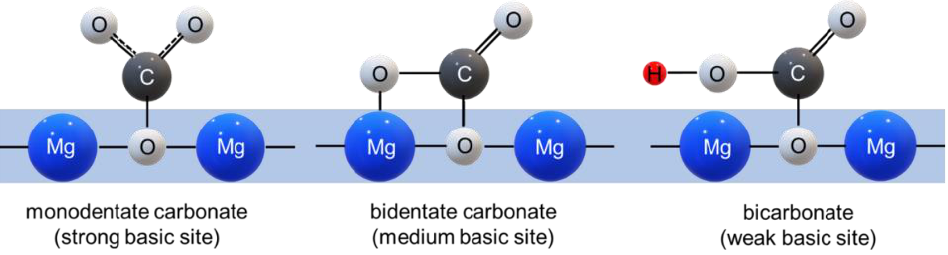
Figure 3. Formation of the carbonate species monodentate carbonate, bidentate carbonate and bicarbonate during adsorption of CO 2 on MgO-based adsorbents (adapted from [36]). In the adsorption process, the number of basic sites is a key factor. Each adsorption site—weak, medium and strong—is classified according to the desorption temperature that is required. The desorption temperature of weak basic sites is lower than 473 K, the des- orption temperature of medium basic site lies between 473 and 573 K, and the desorption temperature of strong basic sites is higher than 573 K [36]. The strong bonding that occurs between CO 2 and Mg 2+ and/or O 2 − is responsible for the formation of bidentate and mon- odentate carbonate with desorption temperatures > 573 K, while the interaction of hydroxyl groups (OH − ) entails the formation of bicarbonate at desorption temperatures < 373 K [36]. It was concluded that the strength of the basic sites in MgO depends on the number of coordinated electronegative metal ions. Thus, this can be enhanced with a high surface area that facilitates an abundant number of O 2 − sites